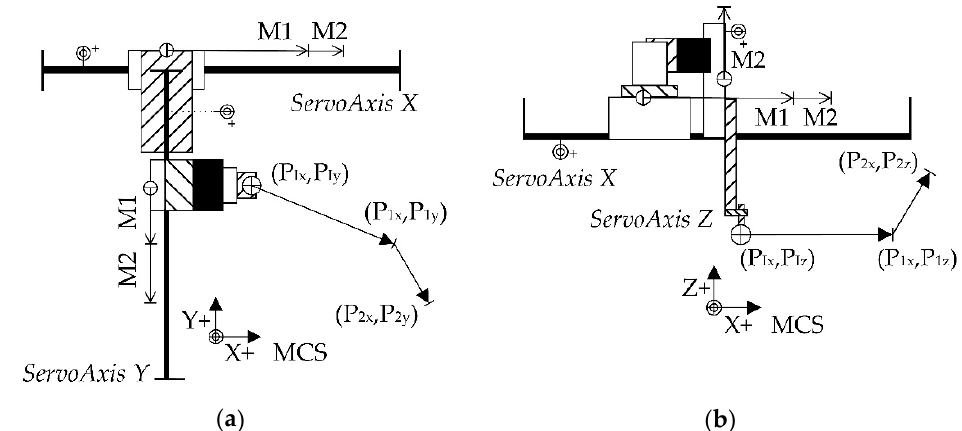
Figure 14. Combination of the simplification of mechanical drawings and trajectory representa- tion. ( a ) Top view. ( b ) Side view.